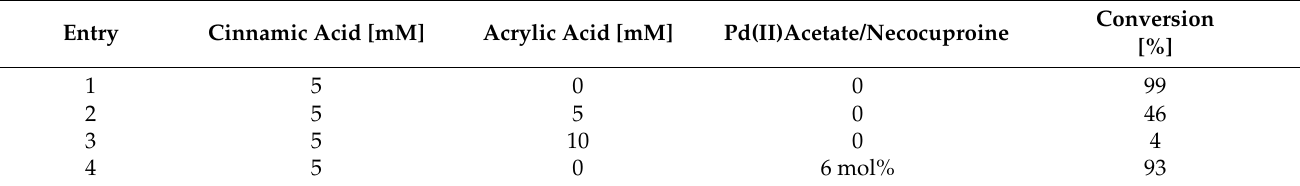
Table 3. Conversion of isolated 1b to 1c with increasing acrylic acid